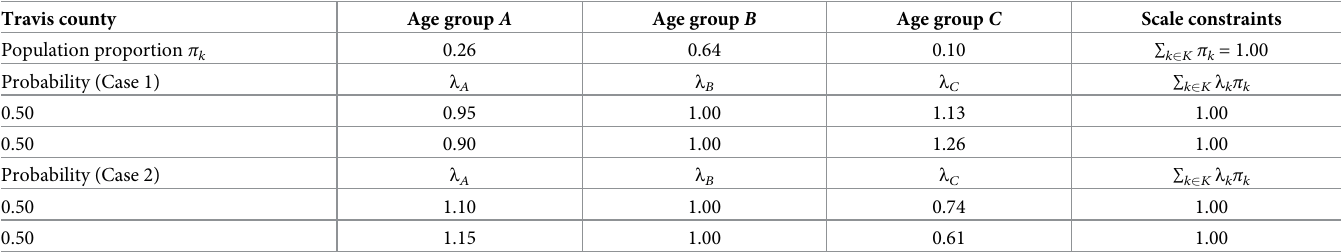
Þ used in this study for Travis county. c